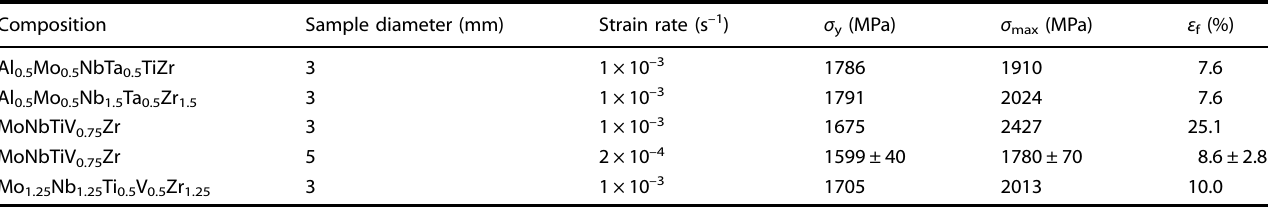
Table 1. Compression yield strength, σ y , maximum strength, σ max , and fracture strain, ε f , of the reference and predicted compositions at room temperature.